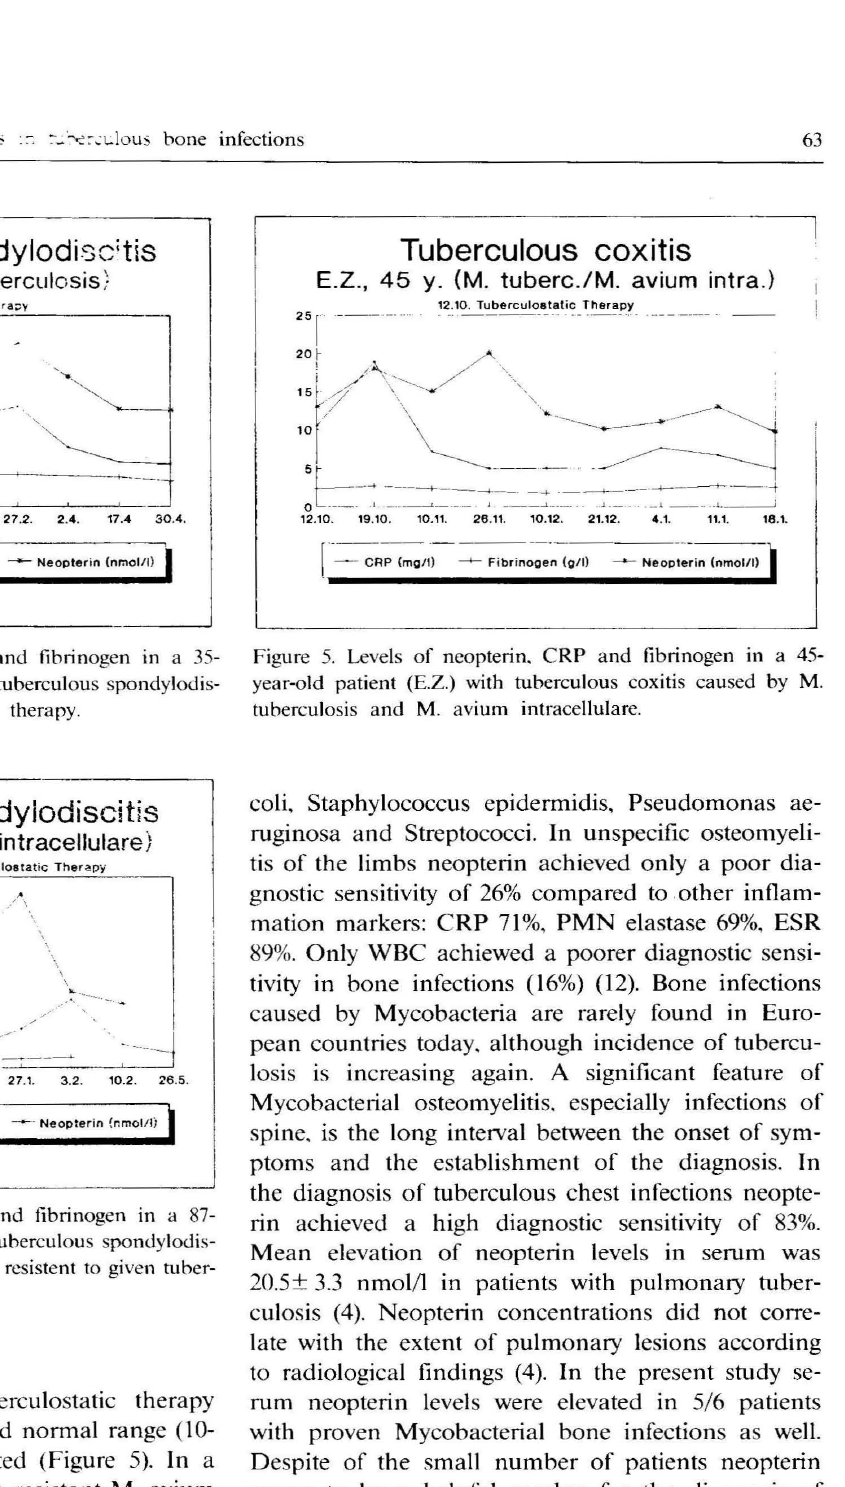
Figure 4. Levels of neopterin. CRP and fibrinogen in a 87- year-old patient (AK) suffering from tuberculous spondylodis citis caused by M. avium intracellulare resistent to given tuber culostatic therapy.